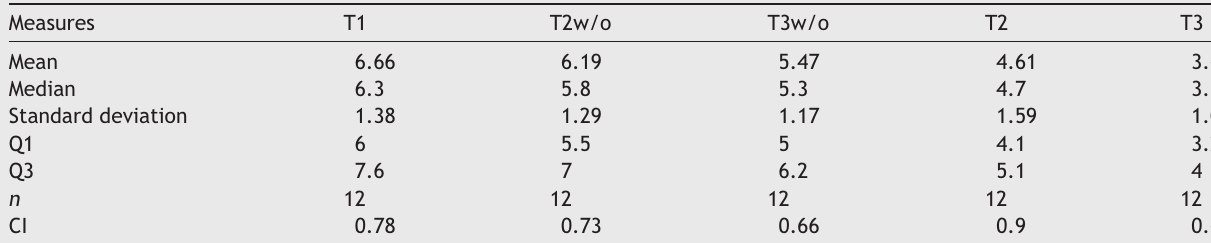
Descriptive statistics and comparative study among time points of evaluation for the perception of sound intensity (dB SL) of tinnitus in the left ear (TG).